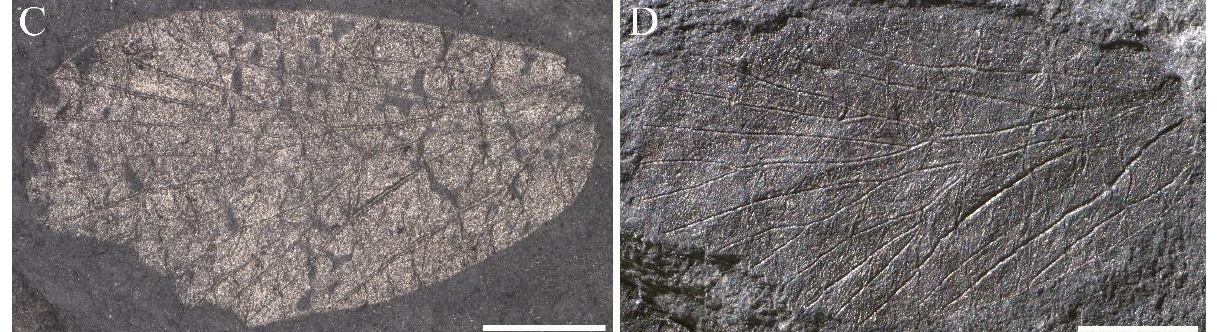
Figure 9. Sinoagetopanorpa minuta sp. nov., NIGP200920 (holotype). ( A , B ) Photographs of part; ( C , D ) Photographs of counterpart; ( A , C ) were taken when specimens were immersed under 70% alcohol in vertical reflected light; ( B , D ) were taken in oblique reflected light. Scale bars represent 1 mm in ( A – D ).